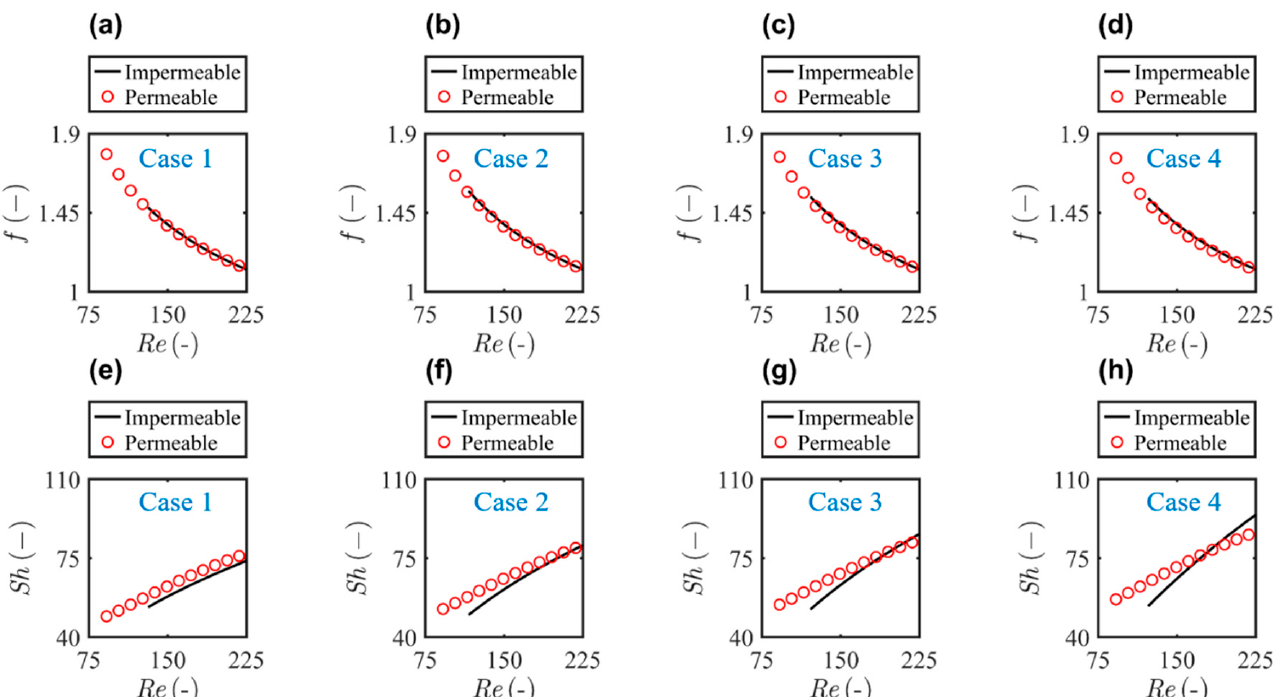
Figure 7. The friction coefficient ( f ) and Sherwood number ( Sh ) with respect to various Reynolds numbers ( Re ) using the impermeable wall model and the permeable wall model for Case 1 ( a , e ) ( L P = 1 L m − 2 h − 1 bar − 1 ), ( b , f ) Case 2 ( L P = 3 L m − 2 h − 1 bar − 1 ), ( c , g ) Case 3 ( L P = 5 L m − 2 h − 1 bar − 1 ) and ( d , h ) Case 4 ( L P = 10 L m − 2 h − 1 bar − 1 ).